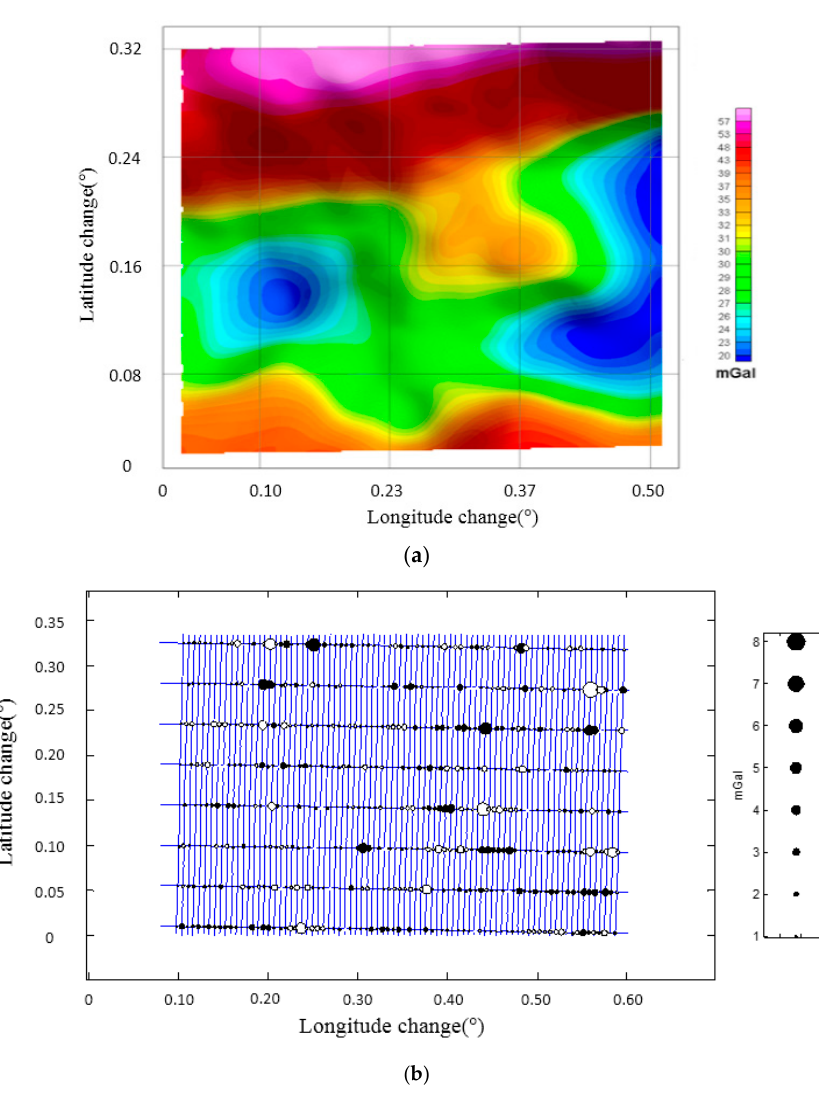
Figure 5. ( a ) Gravity disturbance in the survey area after adjustment; ( b ) Cross-point differences in the survey area after adjustment.